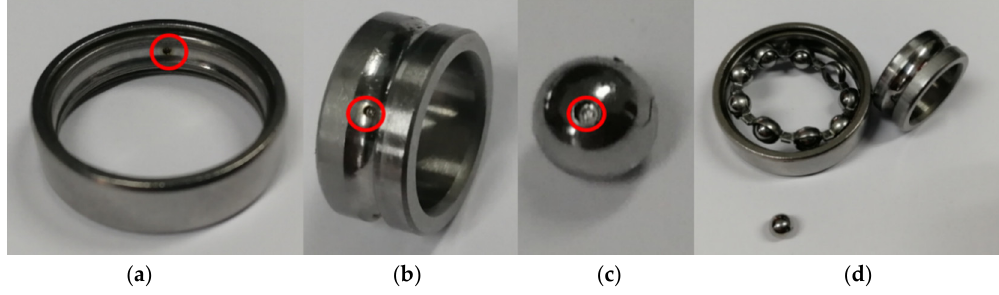
Figure 5. Locations of bearing faults: ( a ) outer race fault; ( b ) ball fault; ( c ) inner race fault; and ( d ) combination of parts.